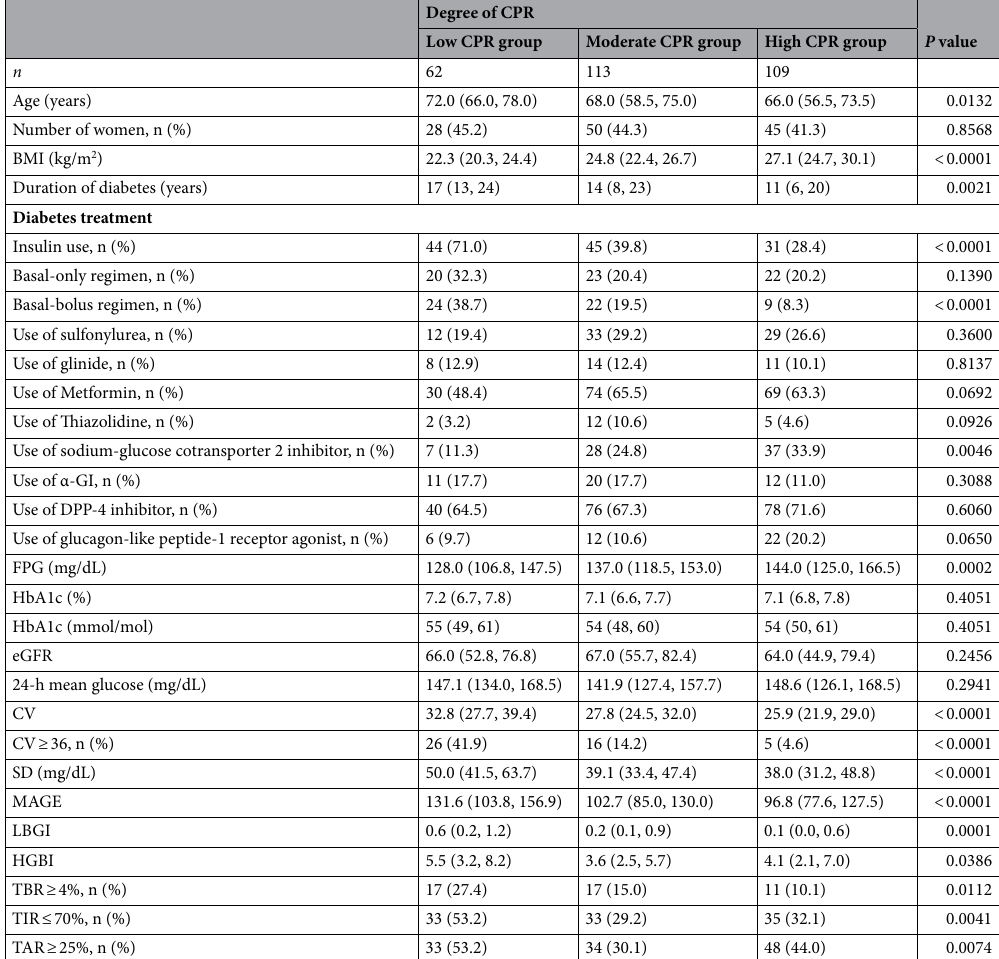
Table 4. Characteristics of the patients, according to their CPR levels. Values are expressed as median (interquartile range), or number (%) of patients in each category. One-way analysis of variance, the Kruskal– Wallis test, or the chi-square test was used to compare the three groups. CPR C-peptide, BMI body mass index, α-GI alpha-glucosidase inhibitor, DPP-4 dipeptidyl peptidase-4, FPG fasting plasma glucose, eGFR estimated glomerular filtration rate, CV coefficient of variation, SD standard deviation, MAGE mean amplitude of glycemic excursions, LBGI low blood glucose index, HBGI high blood glucose index, TBR percentage of time below target glucose range, TIR percentage of time within target glucose range, TAR percentage of time above target glucose